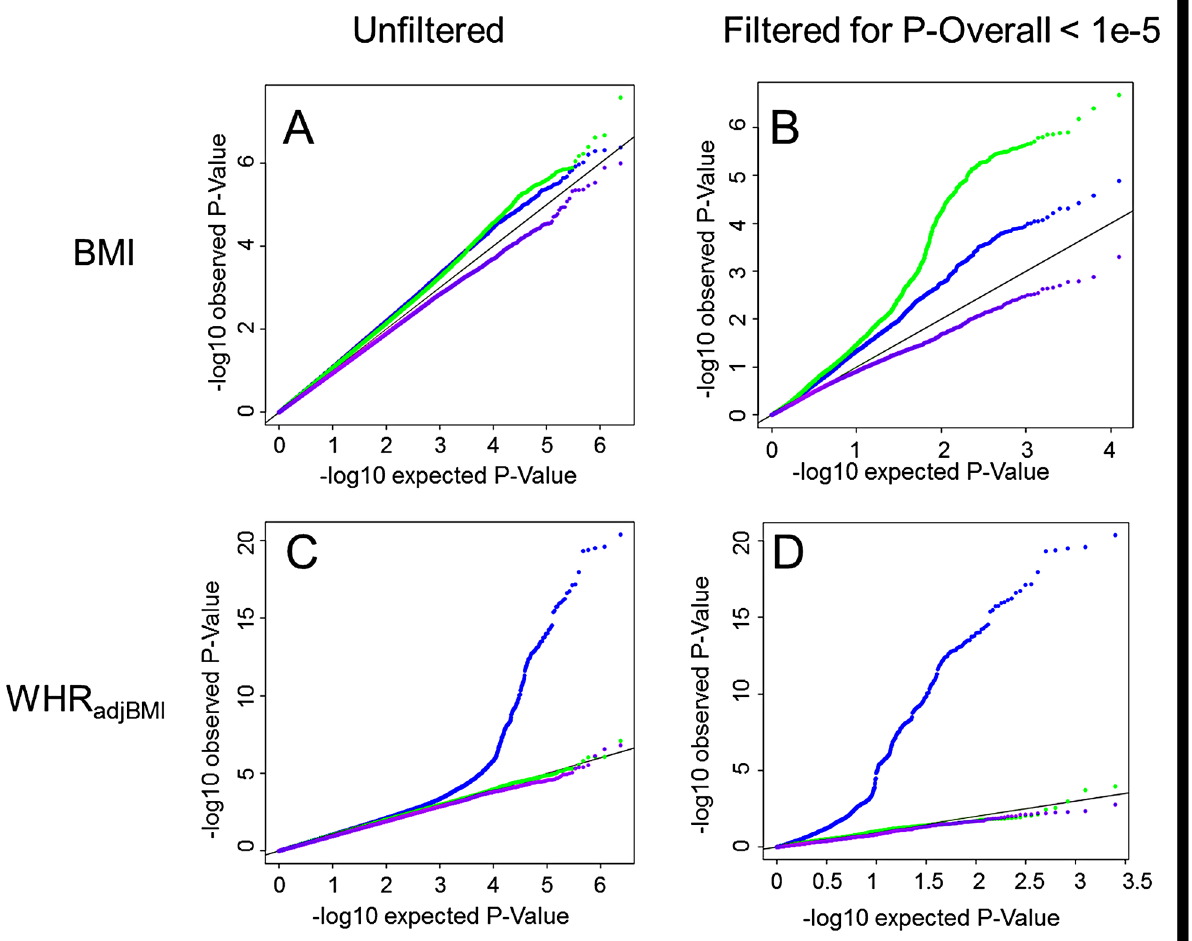
Fig 1. Interaction QQ plots. Quantile-Quantile plots showing P-Values for age-difference ( P agediff , green), sex-difference ( P sexdiff , blue) and age- and sex- difference ( P agesexdiff , purple). For BMI the P-Values are depicted for all SNPs genome-wide (A) as well as for a limited subset of SNPs that survived pre- filtering on the overall association with BMI, P Overall < 1x10 -5 (B). For WHR adjBMI the P-Values are depicted for all SNPs genome-wide (C) as well as for a limited subset of SNPs that survived pre-filtering on the overall association with WHR adjBMI , P Overall < 1x10 -5